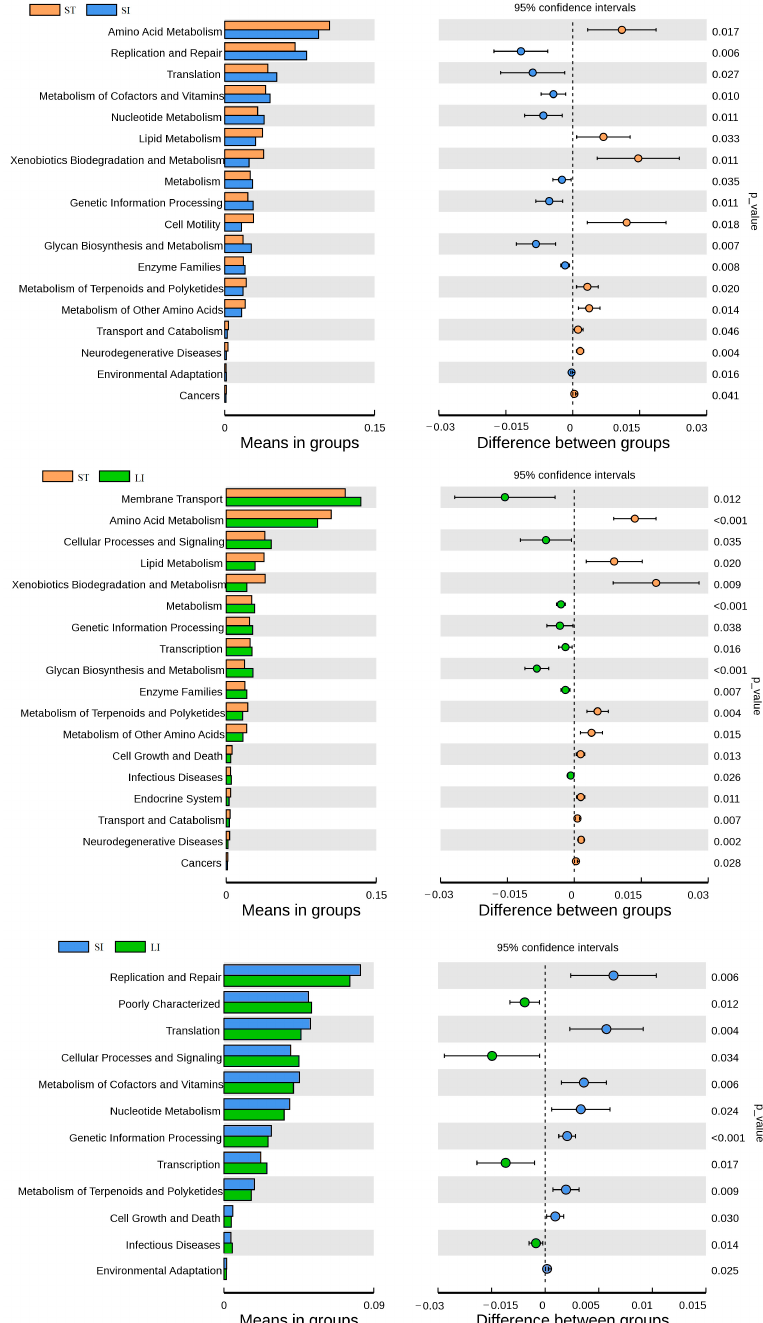
Figure 8. Comparison of the microbial functions (level two, top 20) that were significantly different among the three segments of the gastrointestinal tract. Abbreviations: LI, large intestine; SI, small intestine; ST, stomach.